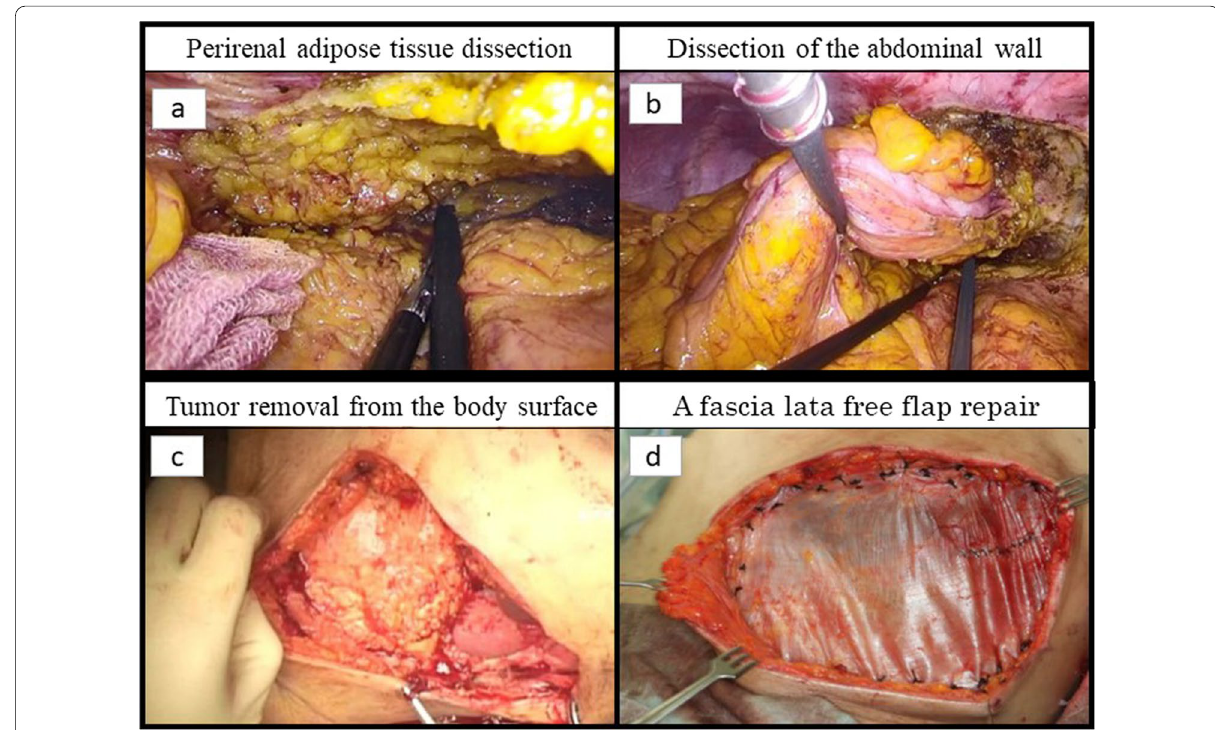
Fig. 2 Laparoscopic tumor resection and surgical repair of the thoracic and abdominal wall defect using a fascia lata-free flap. a Perirenal adipose tissue dissection. b Dissection of the abdominal wall. c Tumor removal from the body surface. d A fascia lata-free flap repair